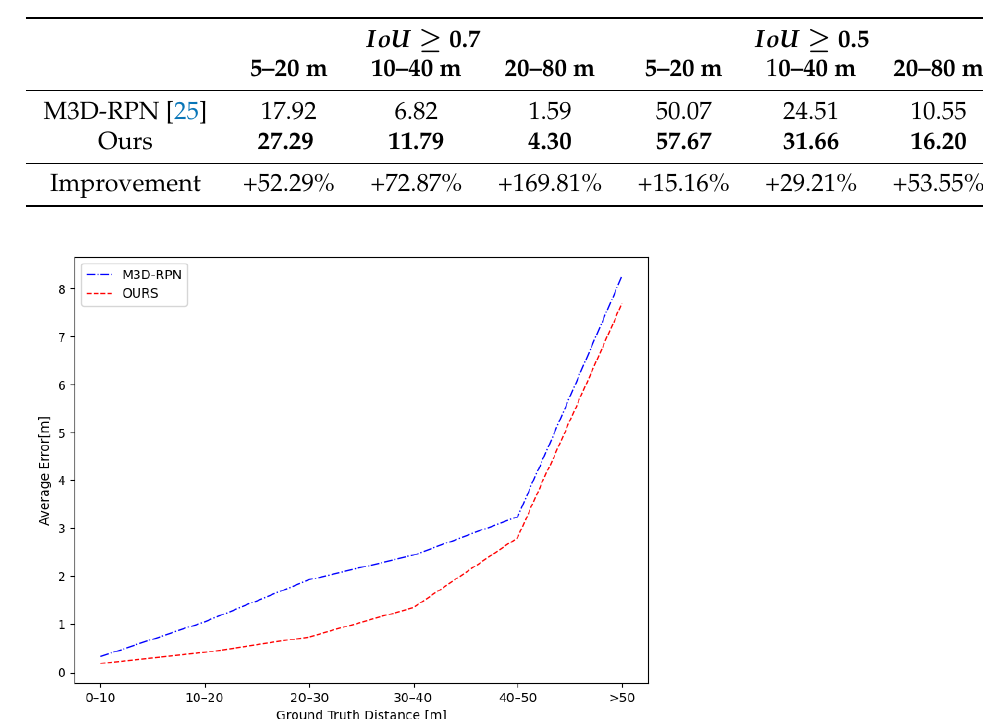
Table 4. The AP 40 for car in different depth ranges on the KITTI validation set. We use bold type to indicate the best result.